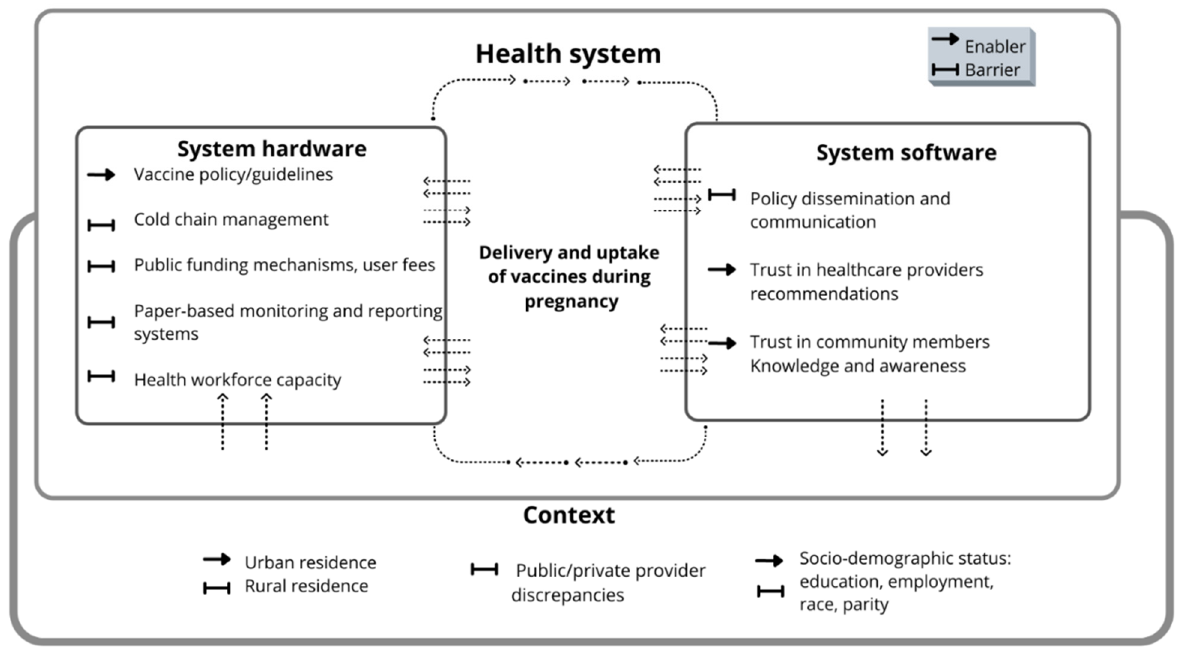
Figure 3. Conceptual framing of health systems determinants of delivery and uptake of maternal vaccines in LMICs. Table 3. Descriptive themes on health systems determinants of uptake of maternal vaccines in LMICs.